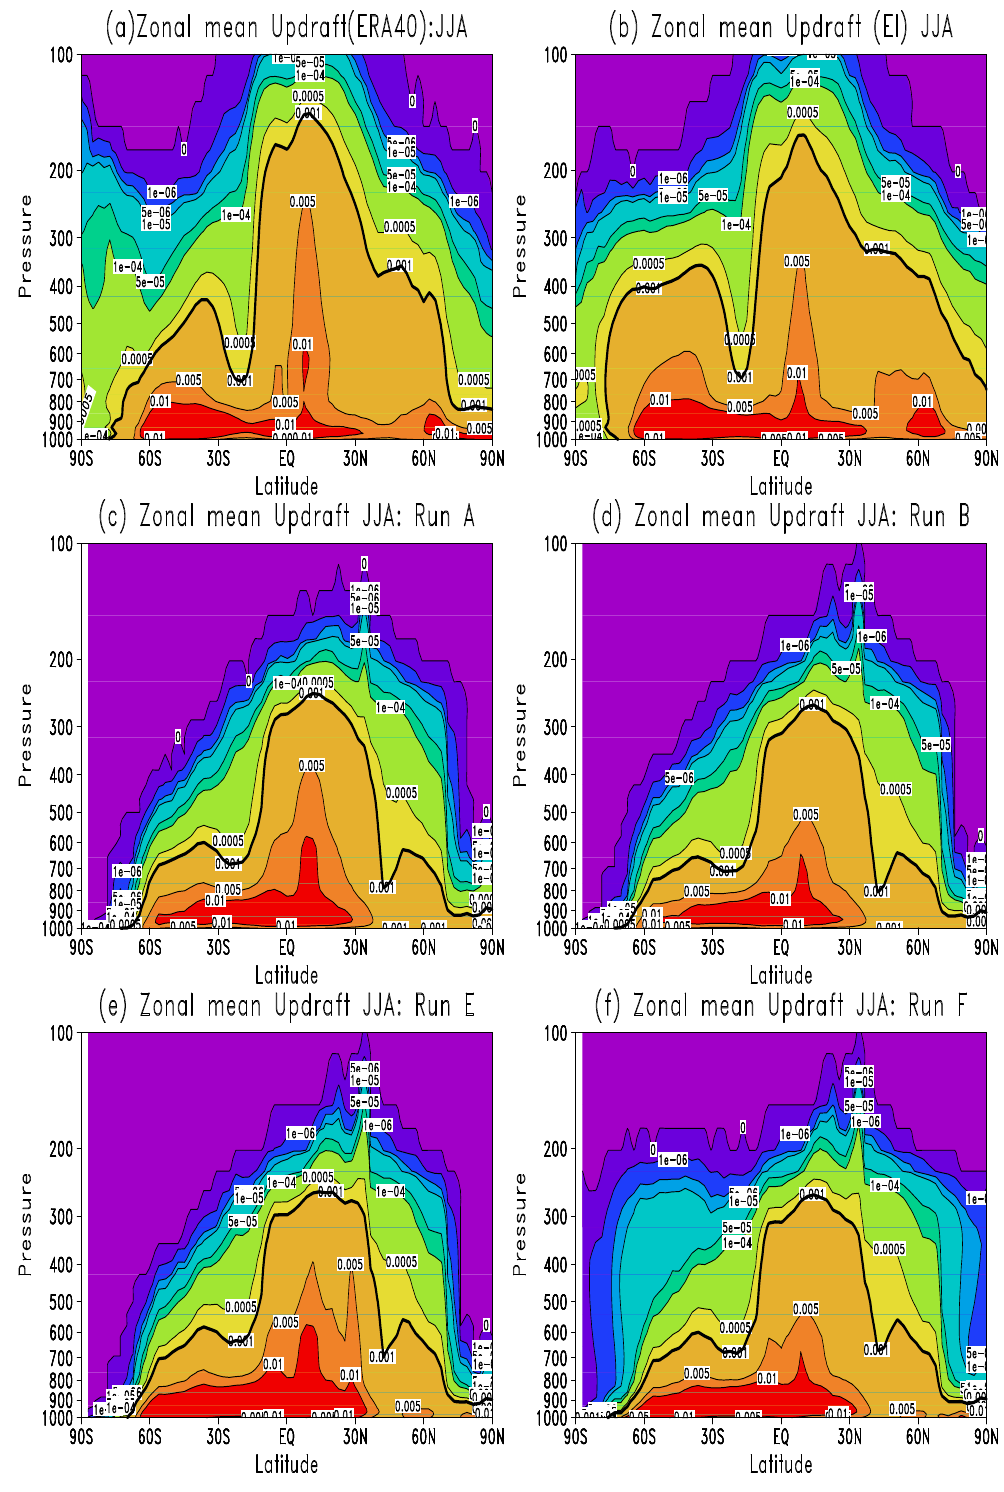
Fig. 3. Zonal mean convective updraft mass flux (kgm − 2 s − 1 ) averaged for JJA from (a) ERA-40 reanalyses (1989–2001), (b) ERA-Interim reanalyses (1989–2005), (c) run “A E40” (1989–2005), (d) run “B EI” (1989–2005), (e) run “E EInewevap” (1989–2005), and (f) run “F EInewconv” (1989–2005). The bold contour indicates 0.001kgm − 2 s − 1 .